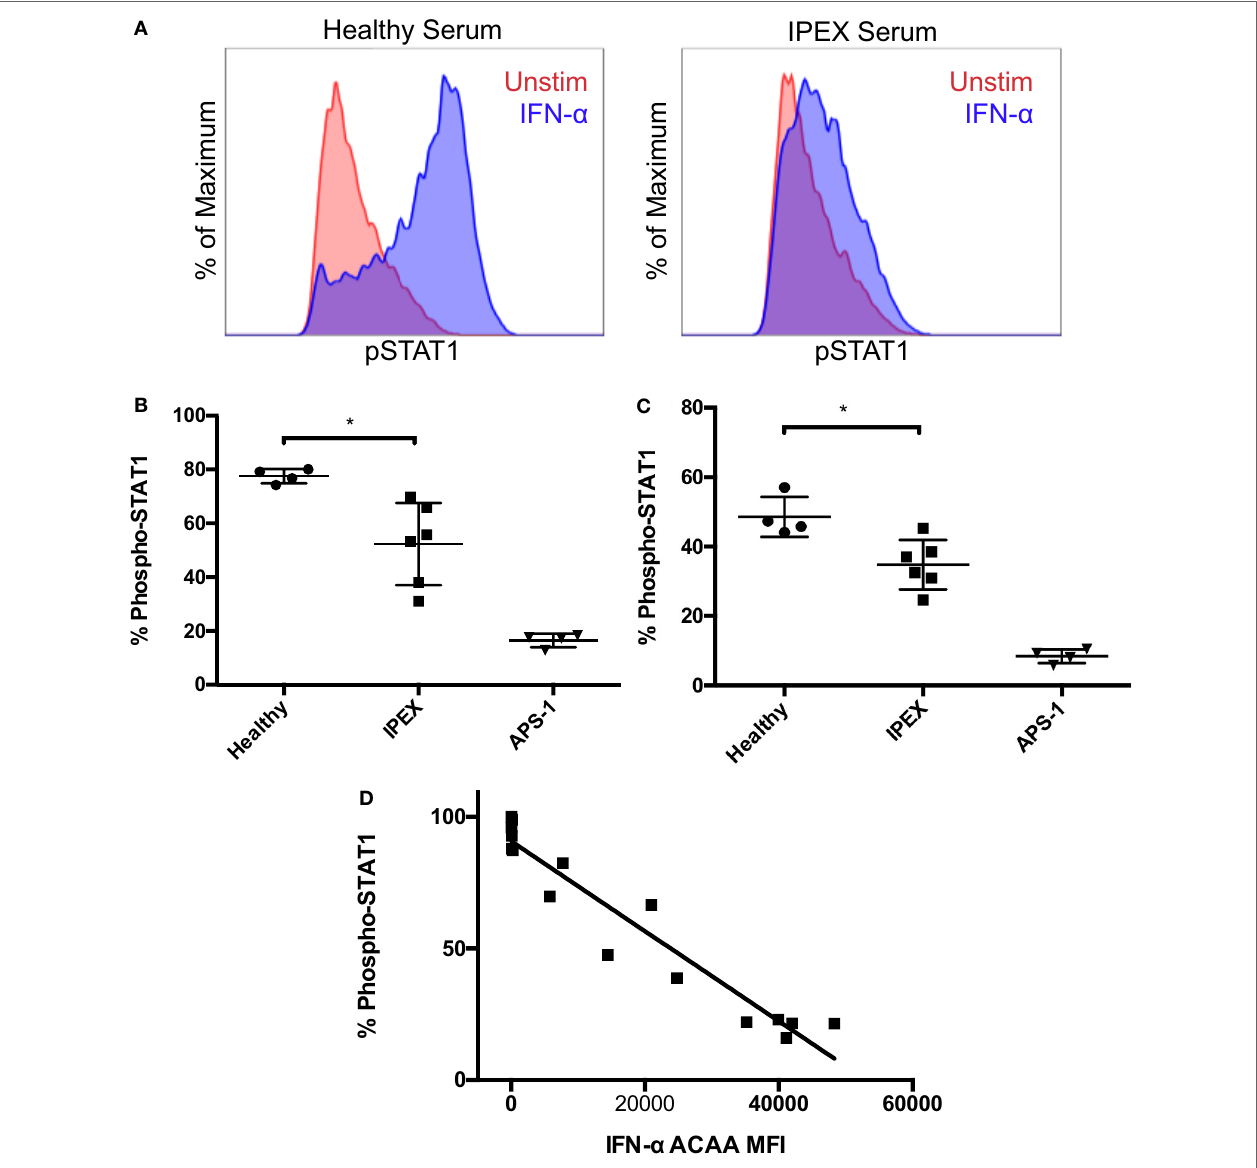
FigUre 2 | Blocking activity of interferon- α (IFN- α ) ACAAs. (a) Aliquots of a healthy donor’s PBMCs were incubated with serum and either stimulated with IFN- α or left unstimulated. Representative flow cytometry plots measuring STAT1 phosphorlyation in CD4 + gated T cells are shown. (B) Percent of CD4 + T cells gated for STAT1 phosphorylation after IFN- α stimulation in the presence of healthy, IPEX, or autoimmune polyendocrine syndrome type I sera ( p = 0.012) or (c) IgG purified from sera ( p = 0.013). Unpaired t -test. (D) Correlation between IFN- α ACAA reactivity and blocking activity ( p < 0.001, r 2 = 0.925), linear